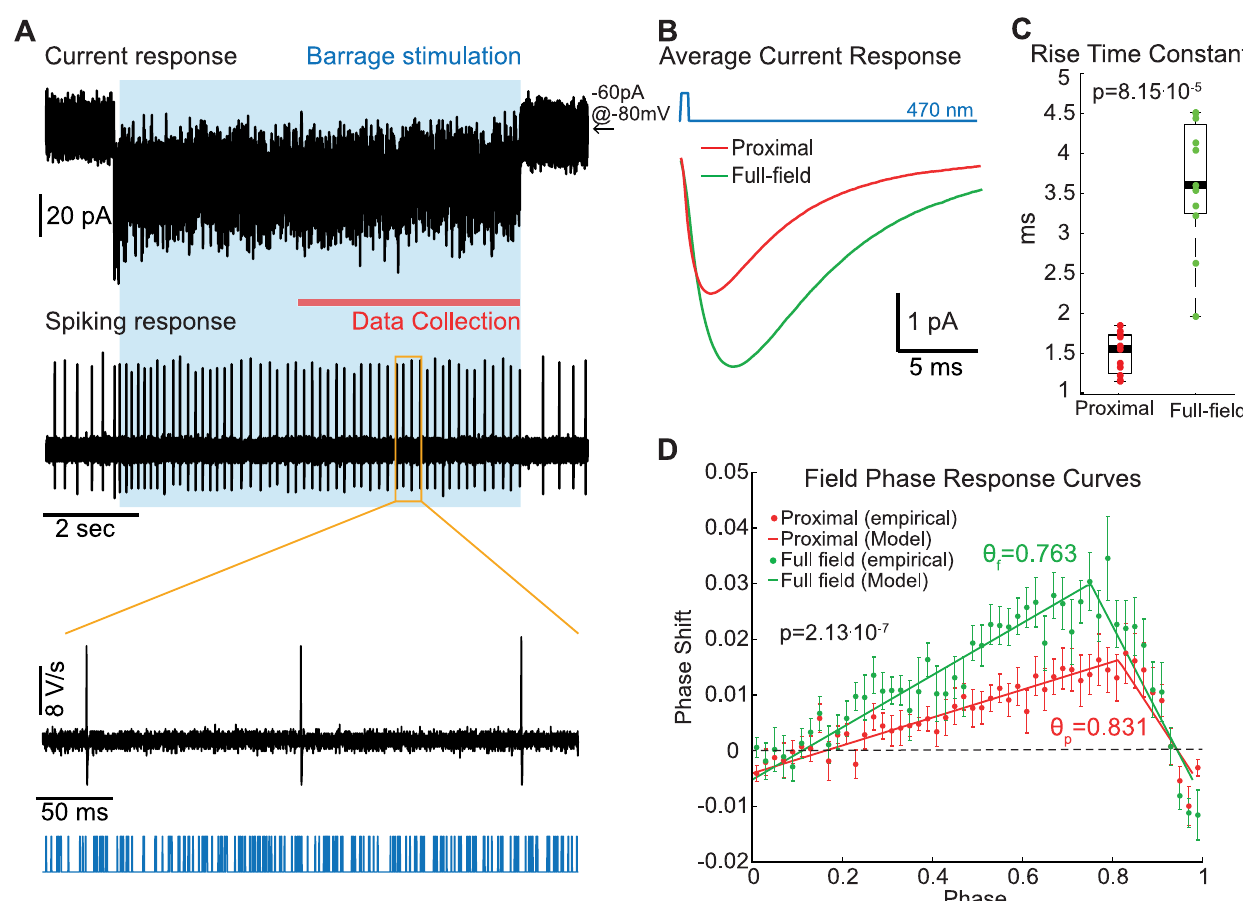
Fig 3. Proximal and full-field barrage stimulations generate distinct PRCs in SNr GABAergic pacemakers. A: ChR2 current and spiking responses (top, black) to barrage stimulation (bottom, blue). The stimulus generated an inward current in whole-cell voltage clamp and an increase in firing rate in cell- attached current clamp. Blue shading indicates stimulation time and red line marks the period in which ChR2 responses have reached steady-state and data is collected. B: ChR2 current responses to a light pulse (blue), averaged over all pulses and all cells (n = 11). Full-field illumination (green) induces a longer response than proximal illumination (red). C: For each stimulation condition, a double exponential was fit to the average current responses for each cell and time constants were extracted ( τ rise , τ decay ). The distribution of rise time constants is significantly different in the two stimulation conditions (p = 8.15 . 10 − 5 , RST), and values are larger in the full-field condition compared to proximal. Central marks indicate the median and box edges represent 25th and 75th percentiles. D: Barrage stimulation was used to measure PRCs corresponding to the two stimulation conditions. Points are the empirical data and lines represent the fitted curves. Proximal and full-field illumination resulted in two distinct PRCs (n = 19, p = 2.13 . 10 − 7 , ANCOVA), with the peak of the full-field curve occurring at an earlier phase than that of the proximal one ( θ f = 0.763 and θ p = 0.831, respectively). Error bars represent standard error of the mean.